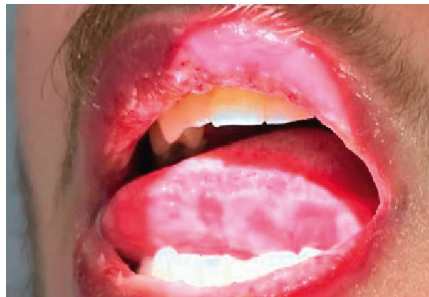
Figure 2: Ulcer on the tongue.